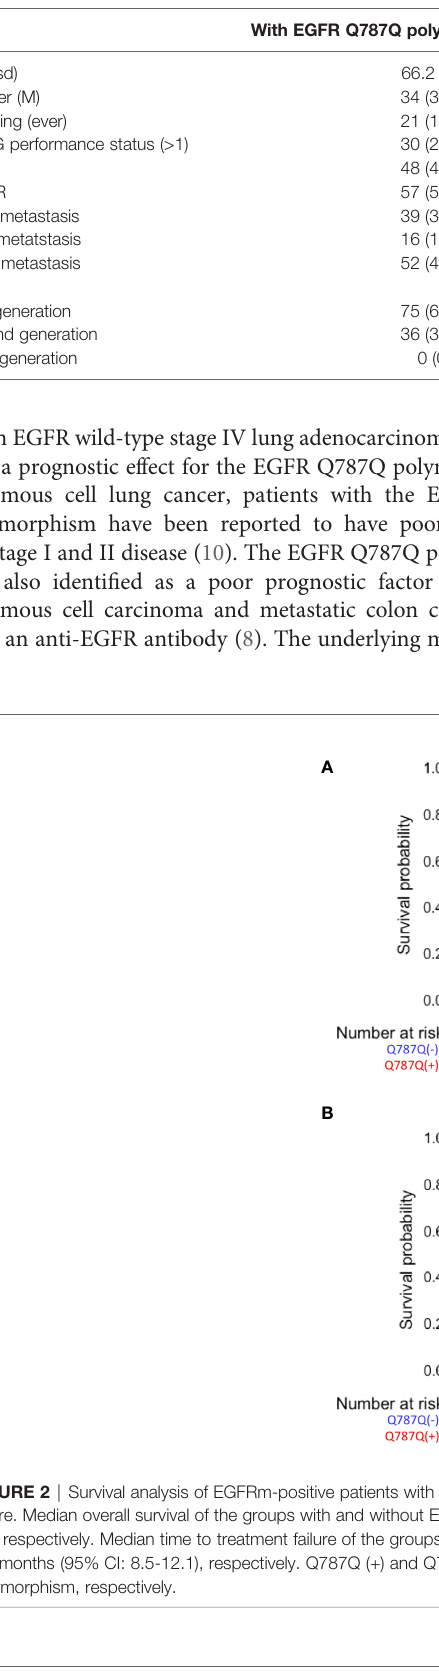
TABLE 1 | Clinicopathological characteristics of TKI-treated EGFRm-positive patients.